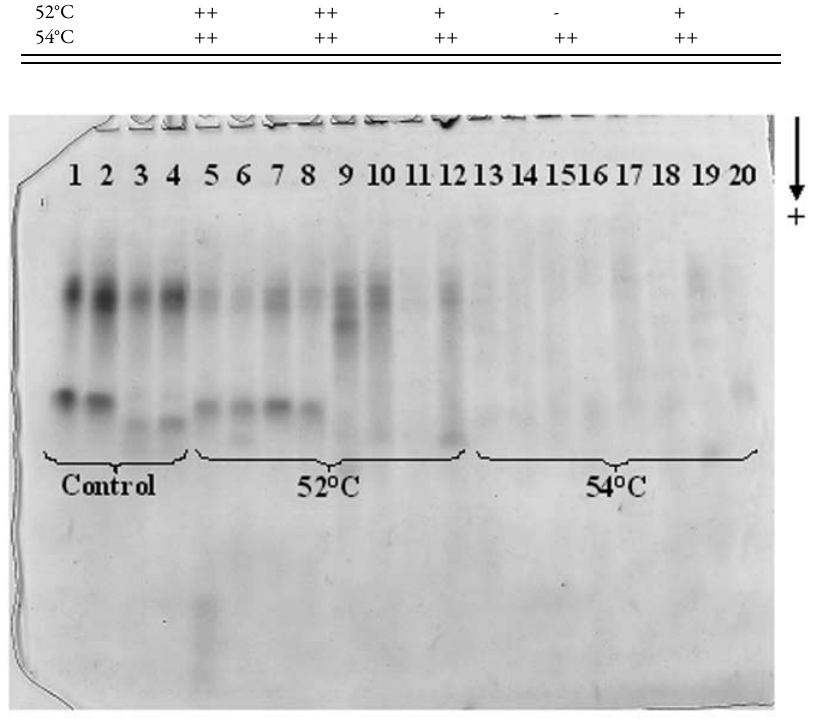
Fig. 2. Thermostability profile of the esterase isoenzymes in the PAGE system from head/thorax extracts of Tetragonisca fiebrigi and Tetragonisca angustula workers. Samples 1-2, 5-8 and 13-16 are head/thorax extracts of Tetragonisca angustula and samples 3-4, 9-12 and 17-20 are head/thorax extracts of Tetragonisca fiebrigi